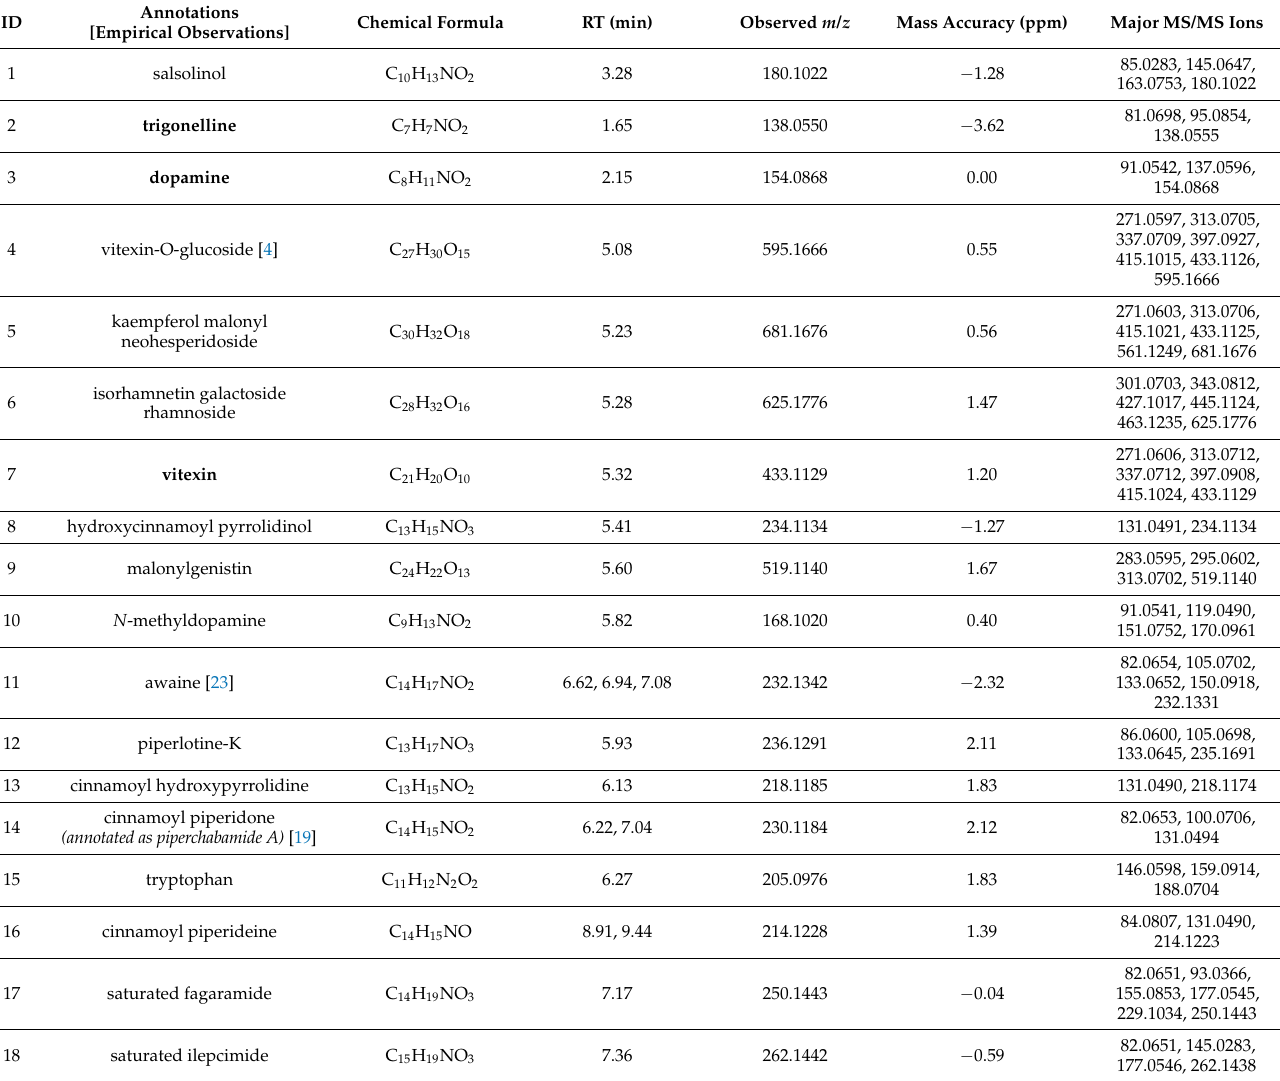
Table 2. Details of the features in the LC-MS/MS data annotated in this work. Multiple RTs indicate chromatographically resolved features with similar mass spectra assumed to be isomers. Multiple RT for a feature indicates isomers. The names of features identified to Level 1 of the Metabolomics Standards Initiative are